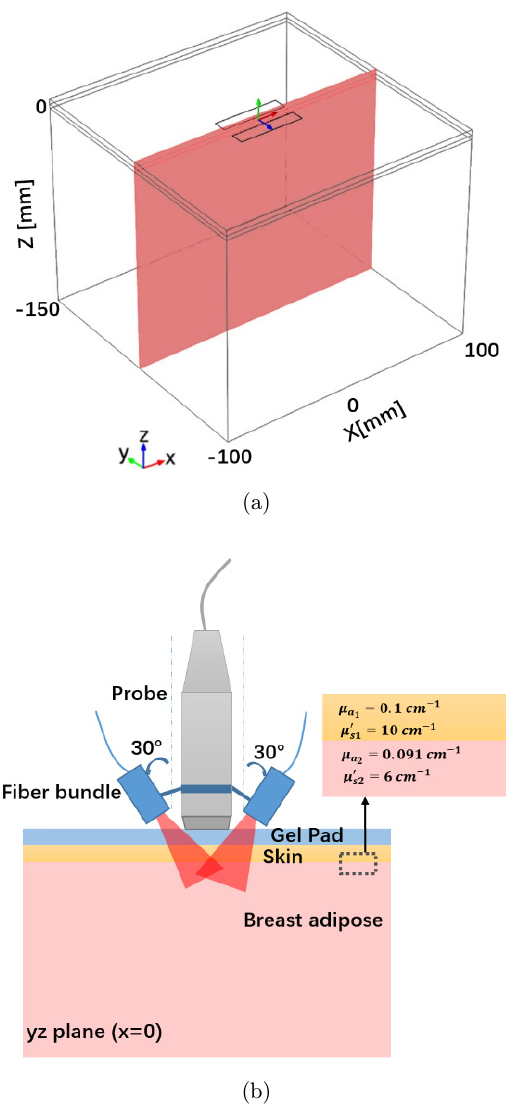
Fig. 5. (a) The shape of breast tissue was assumed to be a cuboid and (b) the schematic diagram of detection setup.